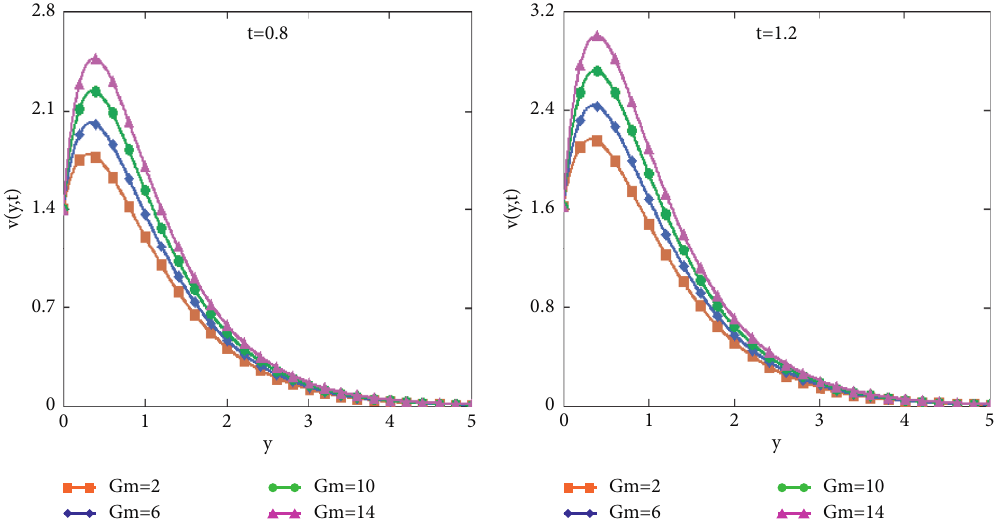
Figure 2: Profiles of velocity v ( y, t ) for various values of the mass Grashof number Gm at R � 1 . 4 ,Q � 0 . 4 , Gr � 9 ,M � . 85 , Sc � 4 . 5 , α � β � c � 0 . 5 ,B � 0 . 2 , and Pr � 4 .